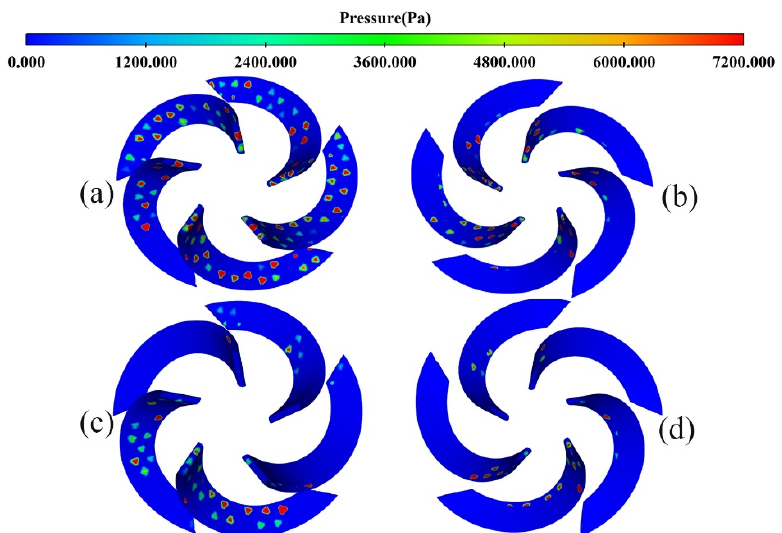
Figure 11. Pressure cloud on the guide vane after being collided with 30–40 mm particles: ( a ) simulation of the pressure on the inner concave surface of the guide vane at 10 s; ( b ) simulation of forces on the outer convex surface of the guide vane at 10 s; ( c ) simulation of the pressure on the inner concave surface of the guide vane at 30 s; ( d ) simulation of the pressure on the inner convex surface of the guide vane at 30 s.